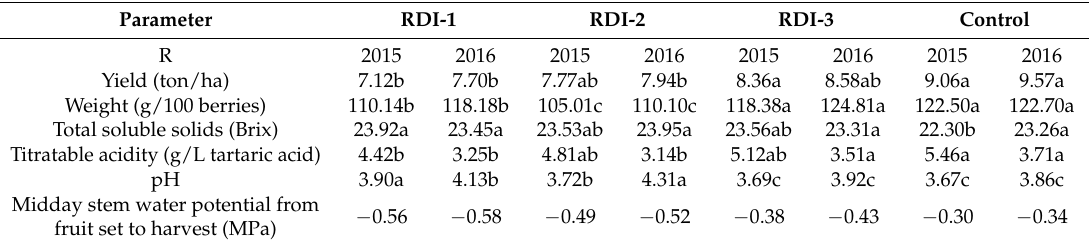
Table 1. Physicochemical parameters of grape berries from the different treatment